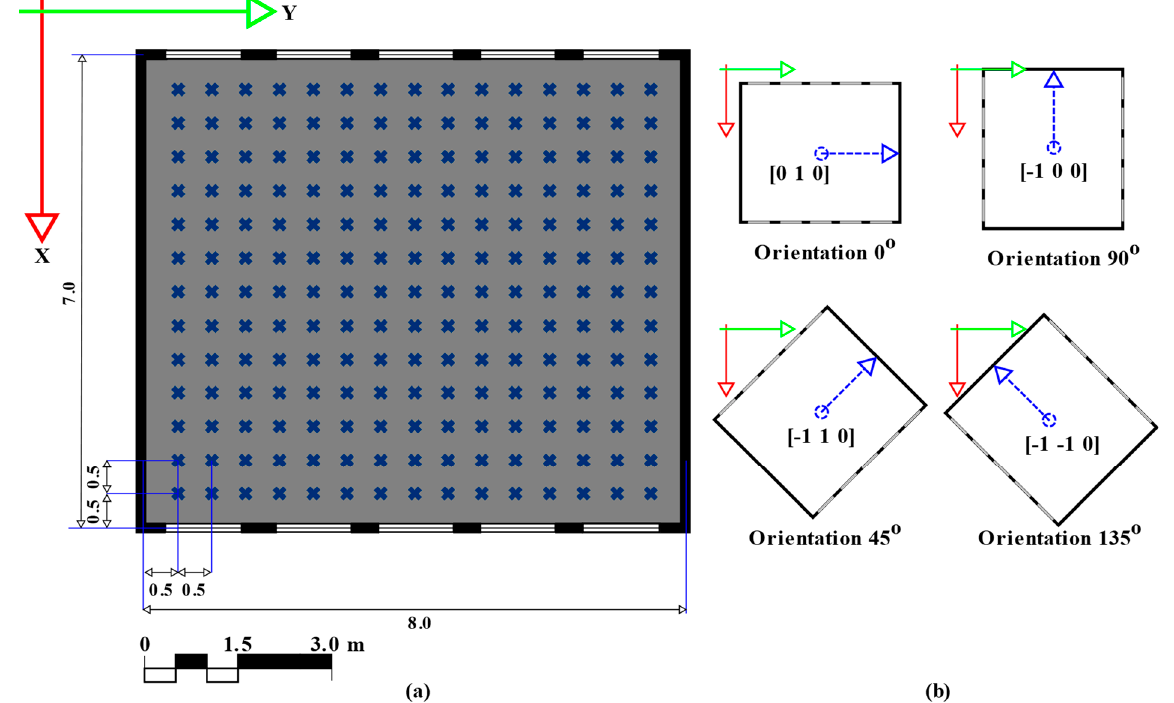
Figure 3. ( a ) Sensor setting at elevation of 0.75 m and ( b ) viewpoint direction for every orientation.